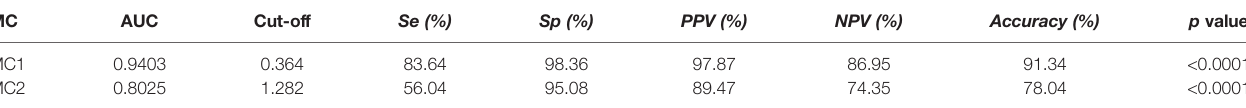
MC1, diagnostic model for distinguishing CRC from healthy individuals; MC2, diagnostic model for distinguishing CRA from healthy individuals; CRC, colorectal cancer; AUC, area under the receiver operating characteristic curve; Se, sensitivity; Sp, speci fi city; PPV, positive predictive values; NPV, negative predictive